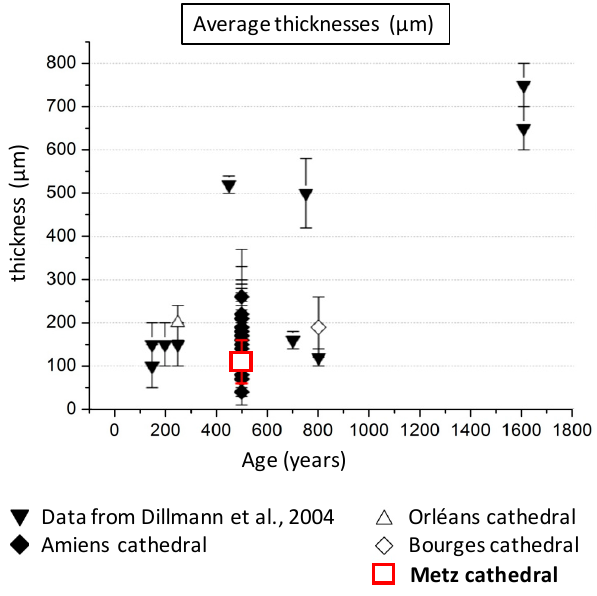
Figure 10. Average thicknesses and standard deviations of CPL measured on ancient low alloy steels in monuments v time. Black down triangle: from [8], losanges: Amiens cathedral [10], up open triangle: Orléans Cathedral [36], open losange: Bourges cathedral [11], red square: Metz cathedral, this study.